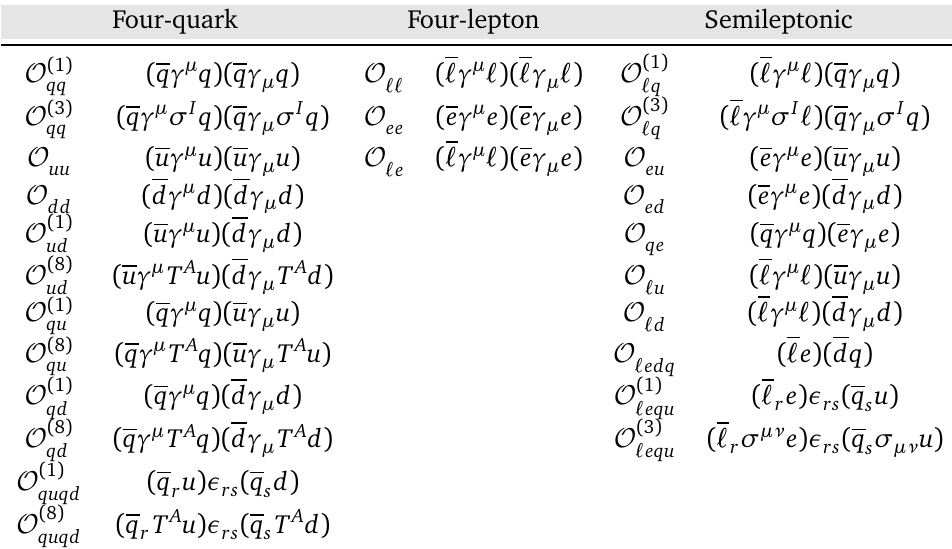
Table 3: Baryon and lepton number conserving operators with four fermions.